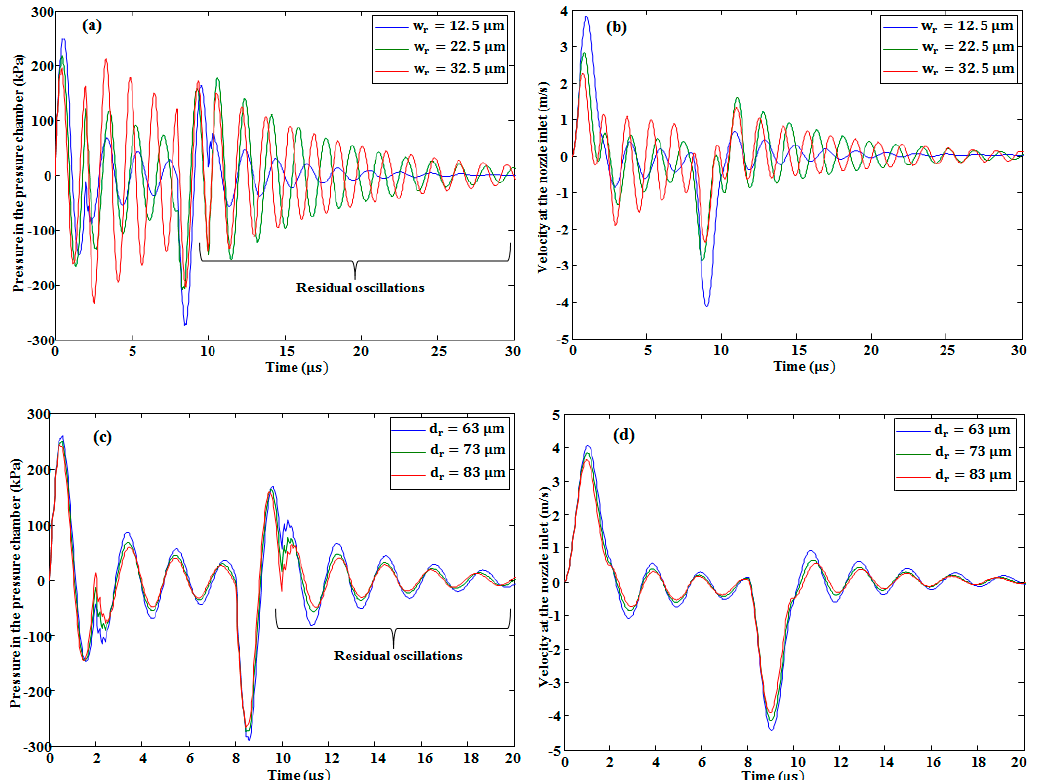
Figure 11. Restrictor width variation effect on ( a ) pressure and ( b ) velocity. Restrictor depth variation effect on ( c ) pressure and ( d ) velocity.